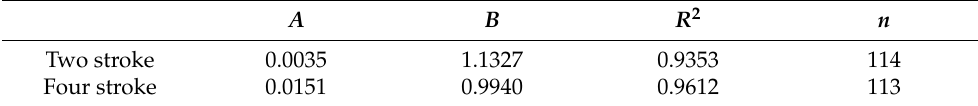
Table 5. Displacement of ICE engines, regression coefficients. Displacement = A · P B